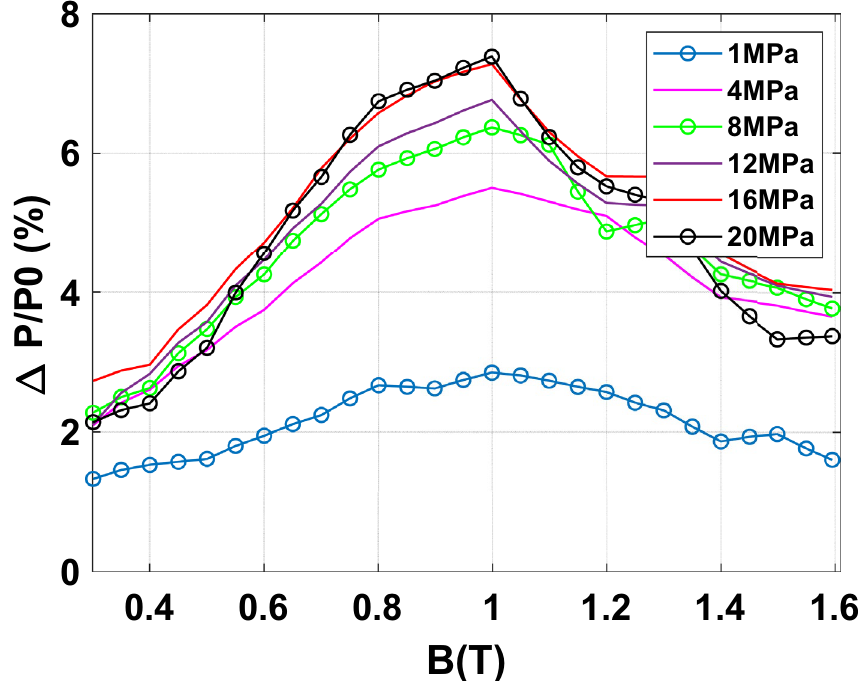
Figure 19. Relative difference on iron losses due to compaction 50 Hz - Homogeneous case.